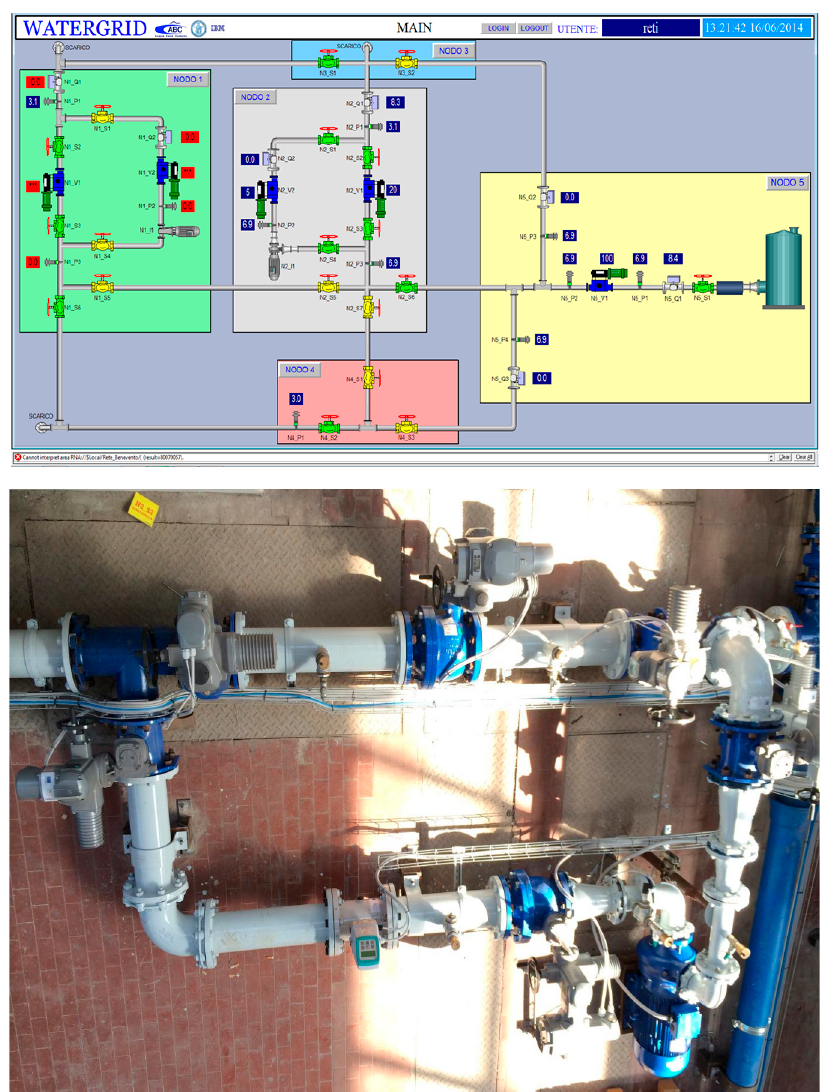
Figure 6. Test bench—water grid of the Department of Civil Construction and Environmental Engineering of the University of Naples Federico II.